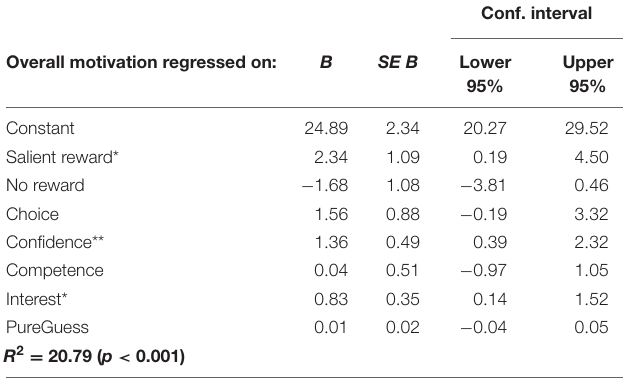
TABLE 4 | OLS regression bias-corrected analysis of effect of salient reward compared to non-salient reward on overall motivation and performance. Overall motivation regressed